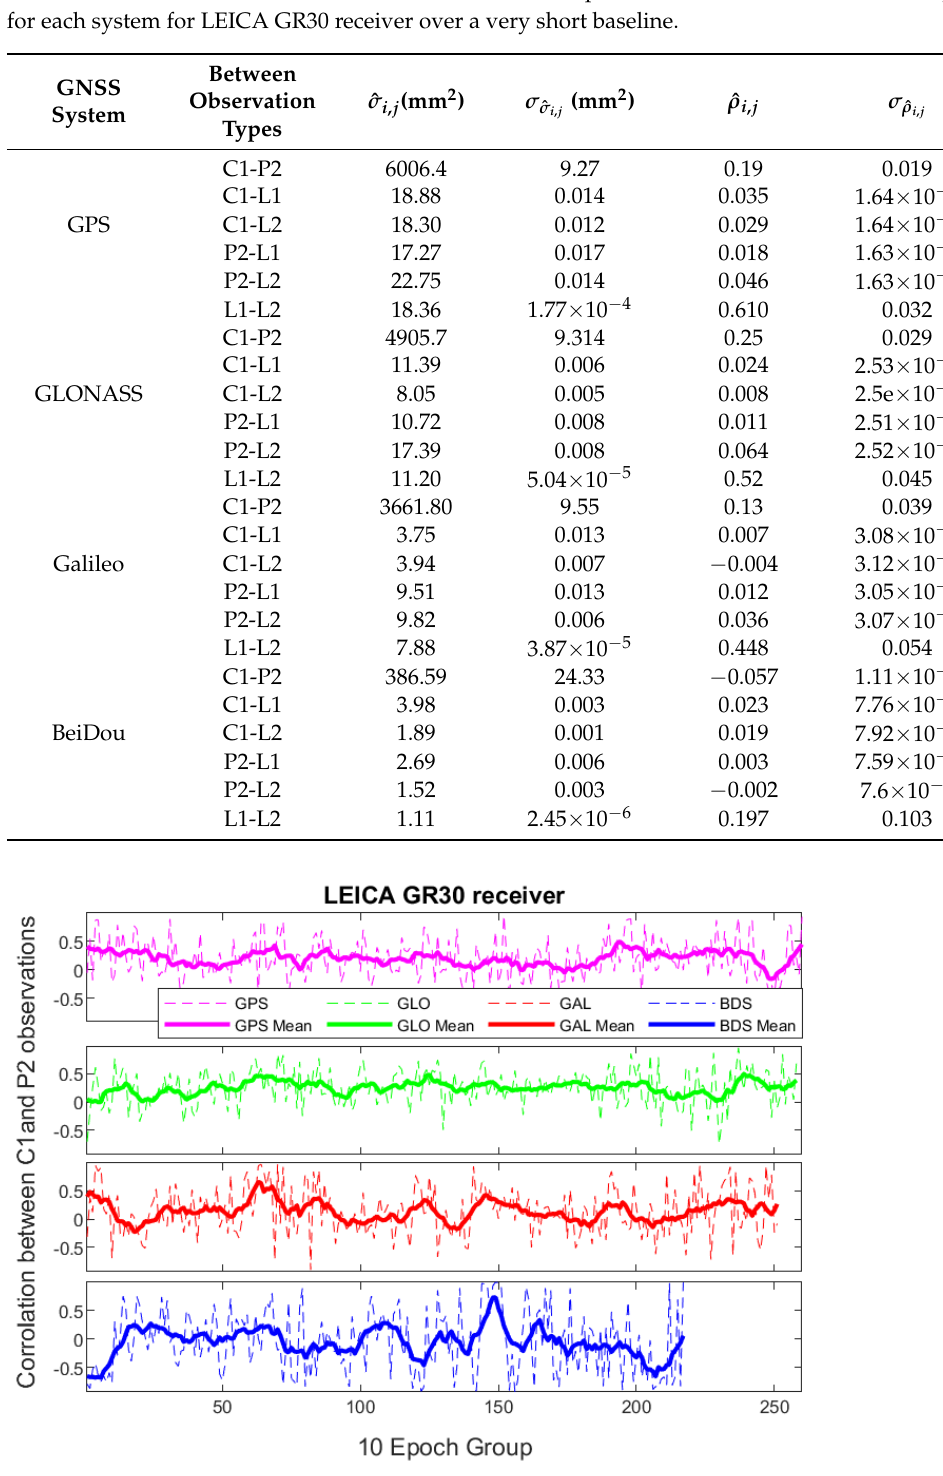
Figure 8. Estimated correlation coefficients between the C1 and P2 observations (dashed line) with their average values in 10 epoch group windows (bold line) over a very short